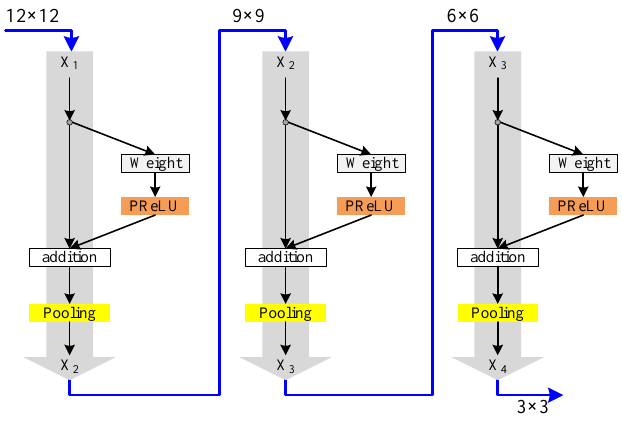
Figure 8. The S-ResNet used in the experiment.